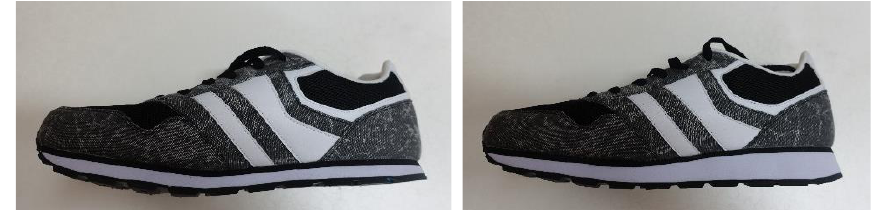
Figure 1. Flat running shoes and conventional running shoes with a 10 mm drop.